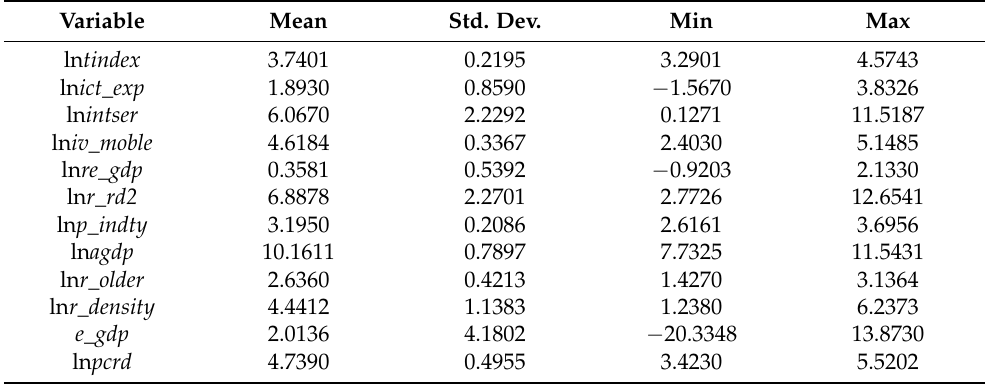
Table 3. Descriptive statistical analysis of